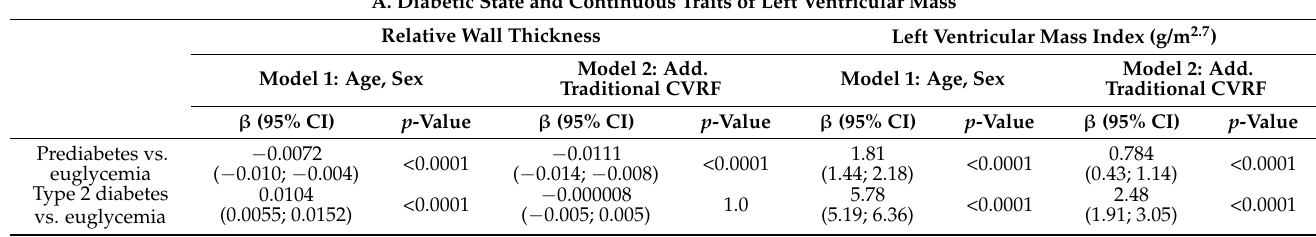
Table 2. The influence of diabetic state on relative wall thickness, left ventricular mass index, and phenotypes of left ventricular